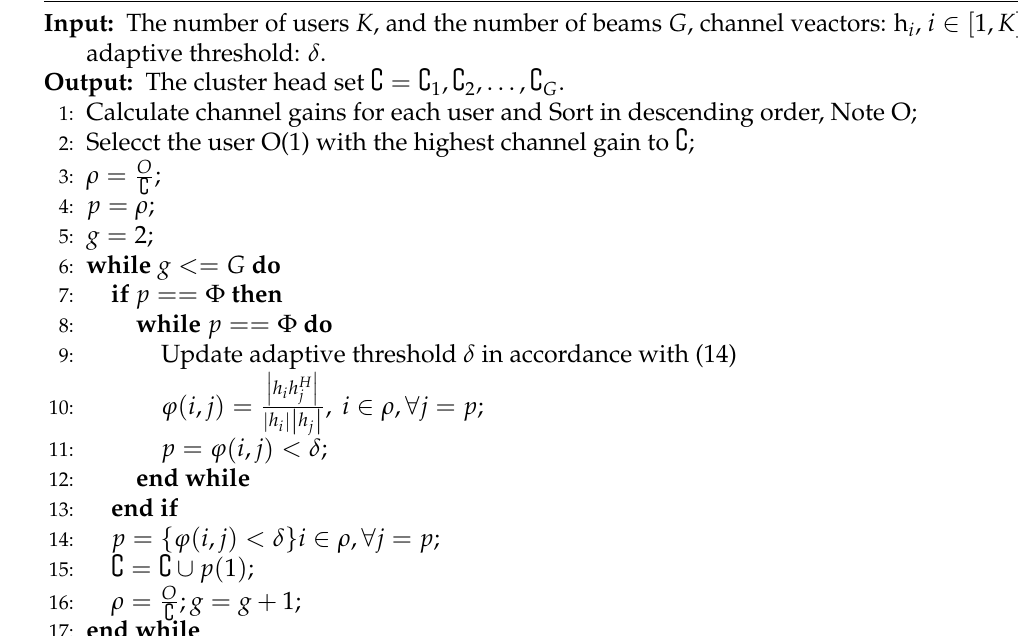
Algorithm 1 Adaptive cluster head selection